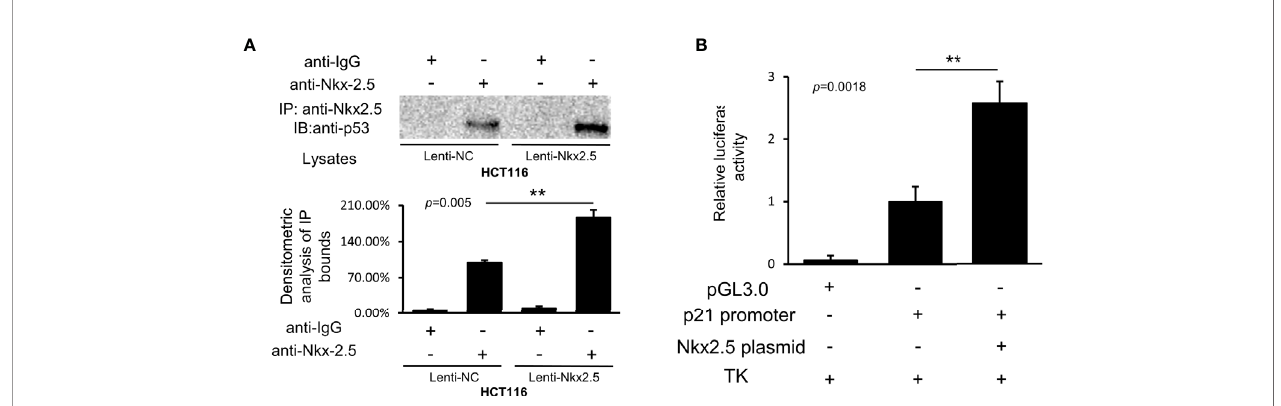
FIGURE 9 | Nkx2.5 interacts with p53 and activates the transcriptional activity of p53. (A) Image of immunocomplexes from Lenti-NC and Lenti-Nkx2.5 HCT116 cells that were blotted with anti-p53 monoclonal antibody. (B) Luciferase reporter assay revealed that Nkx2.5 activated the p21WAF1/CIP1 promoter in HCT116 cells. ** represents P < 0.01; ns represents P ≥ 0.05 (no statistical signi